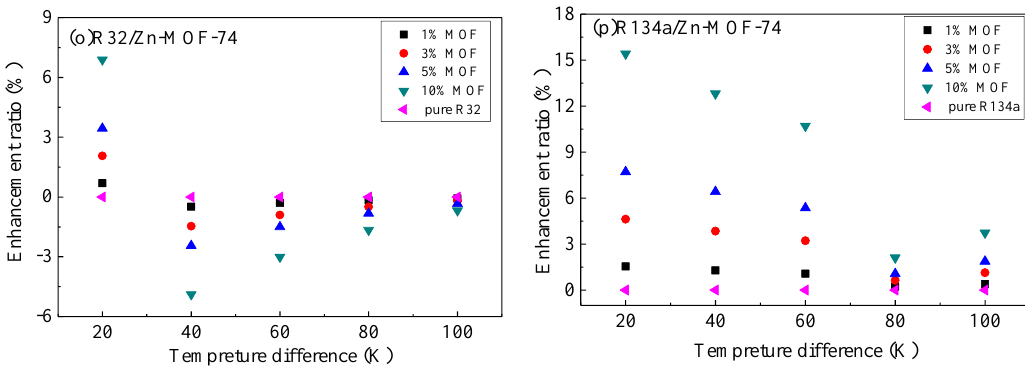
Figure 6. The relationship between the thermal energy storage and temperature difference of the adsorbates (R1234yf, R1234ze, R134a, R32)/MOF-74 mixture at 3,500 kPa. ( a ) R1234ze/Co-MOF-74; ( b ) R1234yf/Co-MOF-74; ( c ) R32/Co-MOF-74; ( d ) R134a/Co-MOF-74; ( e ) R1234ze/Mg-MOF-74; ( f ) R1234yf/Mg-MOF-74; ( g ) R32/Mg-MOF-74; ( h ) R134a/Mg-MOF-74; ( i ) R1234ze/Ni-MOF-74; ( j ) R1234yf/Ni-MOF-74; ( k ) R32/Ni-MOF-74; ( l ) R134a/Ni-MOF-74; ( m ) R1234ze/Zn-MOF-74; ( n ) R1234yf/Zn-MOF-74; ( o ) R32/Zn-MOF-74; ( p ) R134a/Zn-MOF-74.